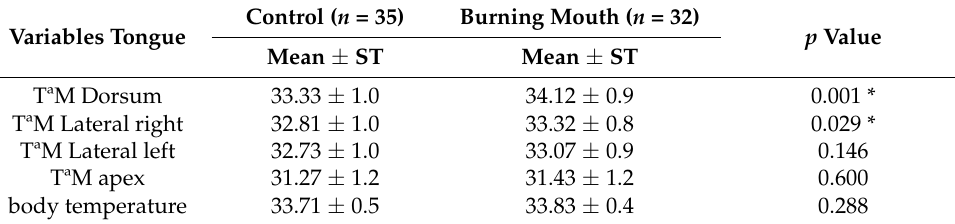
Table 1. Temperature distribution by study group (control and burning mouth